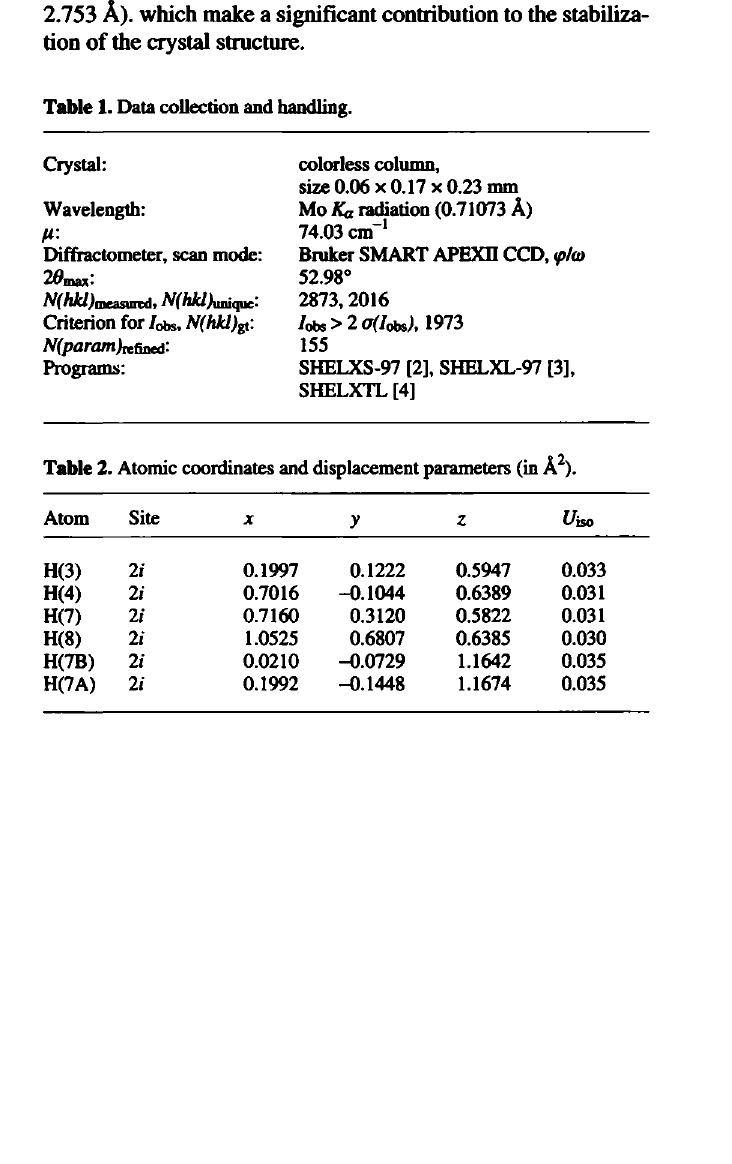
Table 1. Data collection and handling.